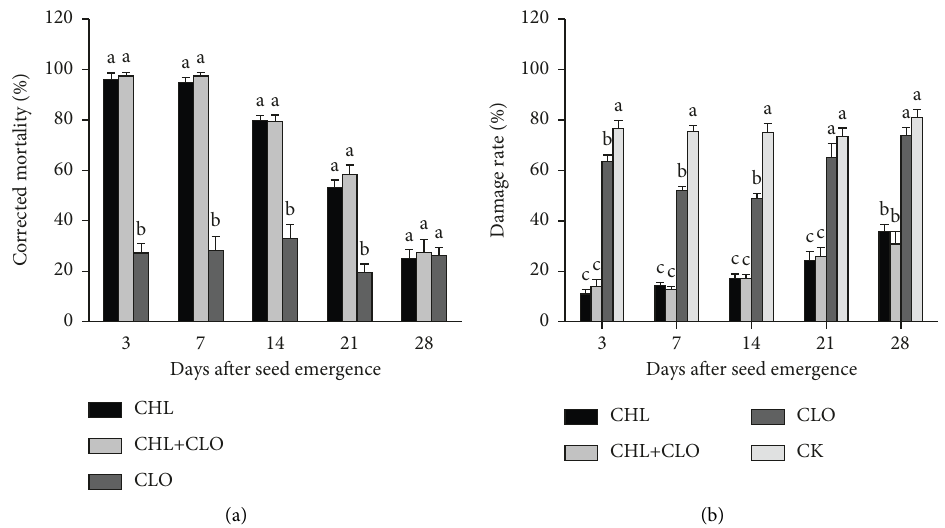
Figure 1: Corrected mortality and damage rates of OAW fed on corn plants treated with CHL, CHL +CLO, and CLO. (a) Corrected mortality. (b) Damage rate. CHL, chlorantraniliprole; CHL+CLO, chlorantraniliprole+clothianidin; CLO, clothianidin; CK, untreated control. All data are expressed as mean ± SE. Different letters above bars indicate significant difference by Tukey’s test ( P < 0 . 05).